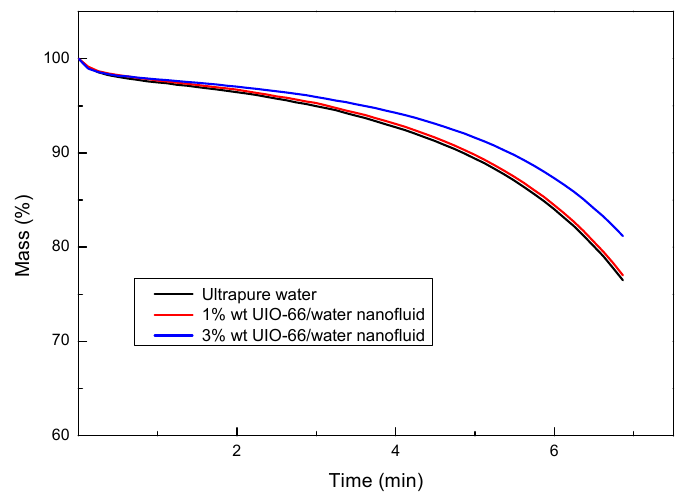
/ H 2 O nanofluids measured by